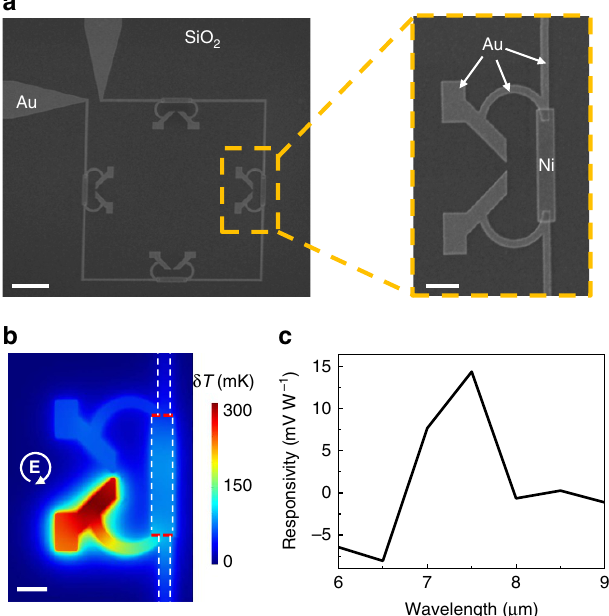
Figure 3 | Thermopile element used for experimental measurements. ( a ) Scanning electron microscopy image of the fabricated thermopile element, consisting of V-shaped antennas (made in Au), C-shaped feed lines (Au), thermocouple junctions (Au (cid:2) Ni) and readout electrodes (top-left corner, Au). Scale bars, 5 and 1 m m (zoom-in). ( b ) COMSOL simulation of the temperature distribution in the antenna structure at the end of a 1- m s-long RCP pulse at l ¼ 7.5 m m and 40Wcm (cid:2) 2 intensity. The antenna structure is simulated to be on top of a l /4 thick SiO 2 spacer on the gold substrate. Scale bar, 1 m m. ( c ) Calculated responsivity of the thermopile in a for RCP light based on thermal simulations performed at various input light wavelengths. The value was deduced from the simulated temperature at A and B thermocouple junctions marked by the red lines in b